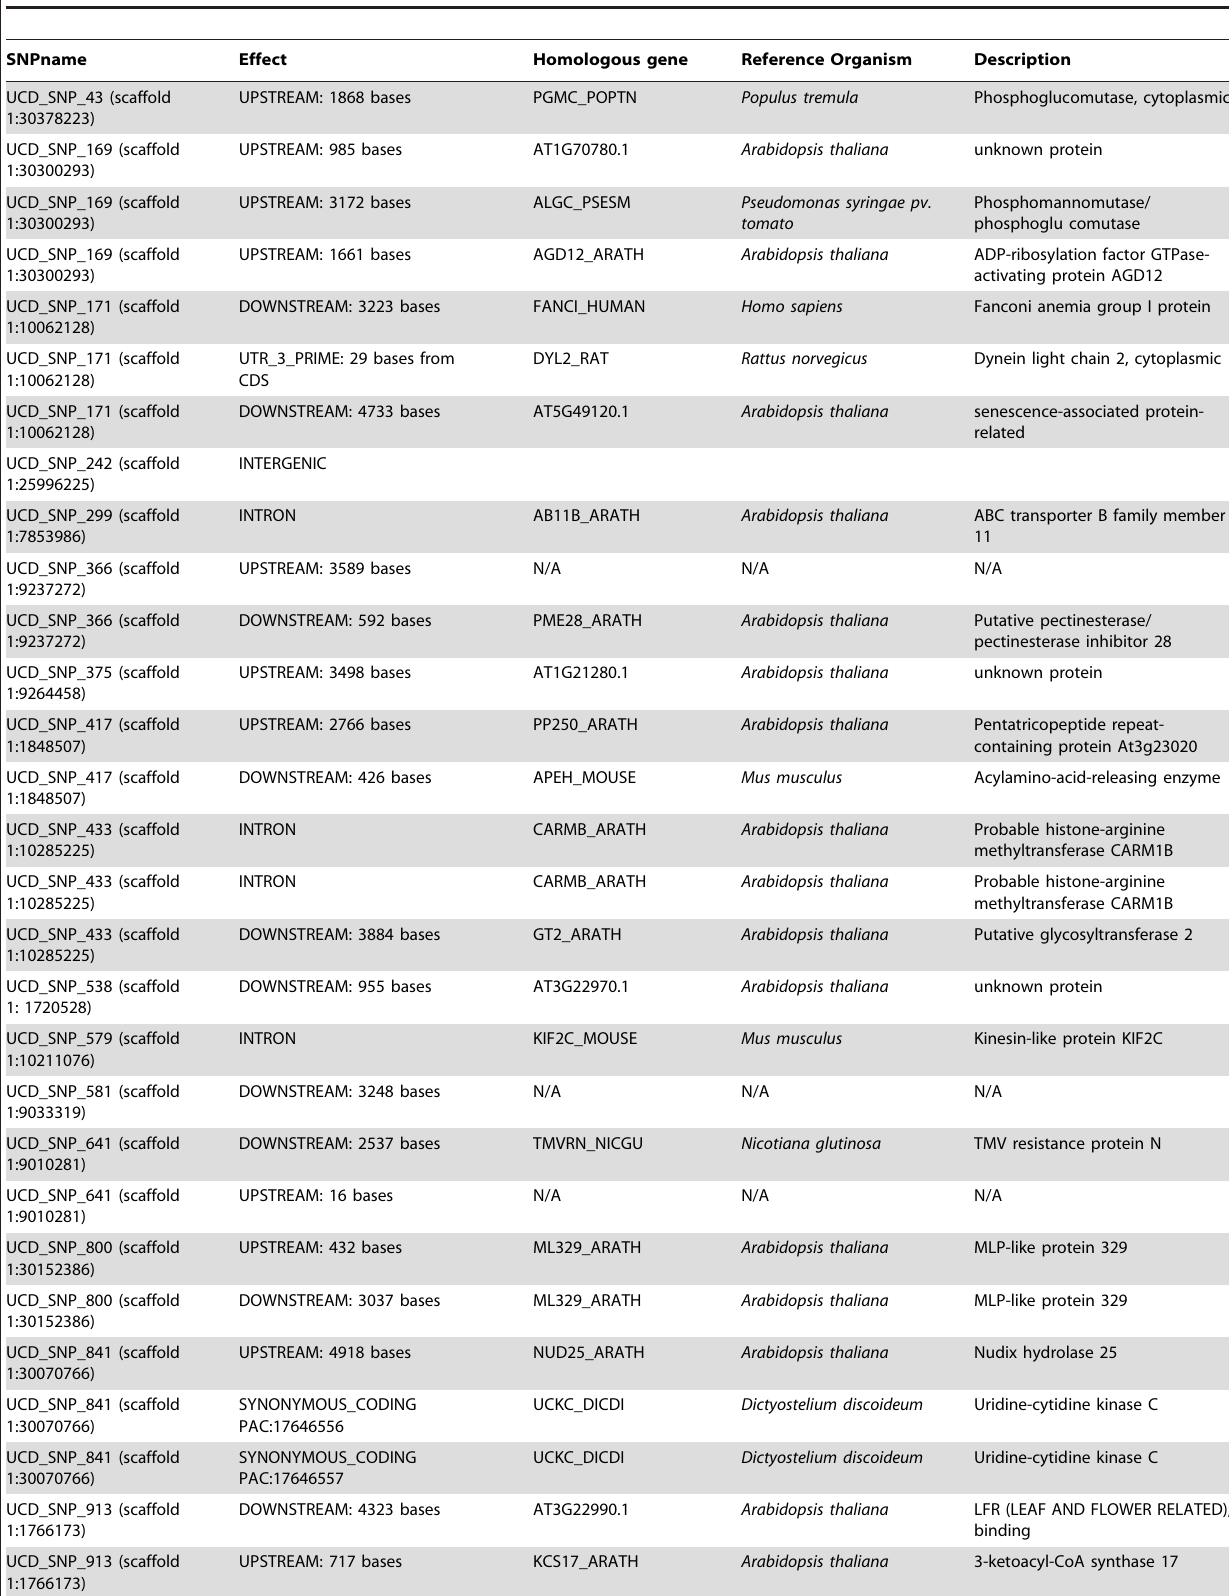
Table 3. The predicted effects of each SNP associated with brown rot